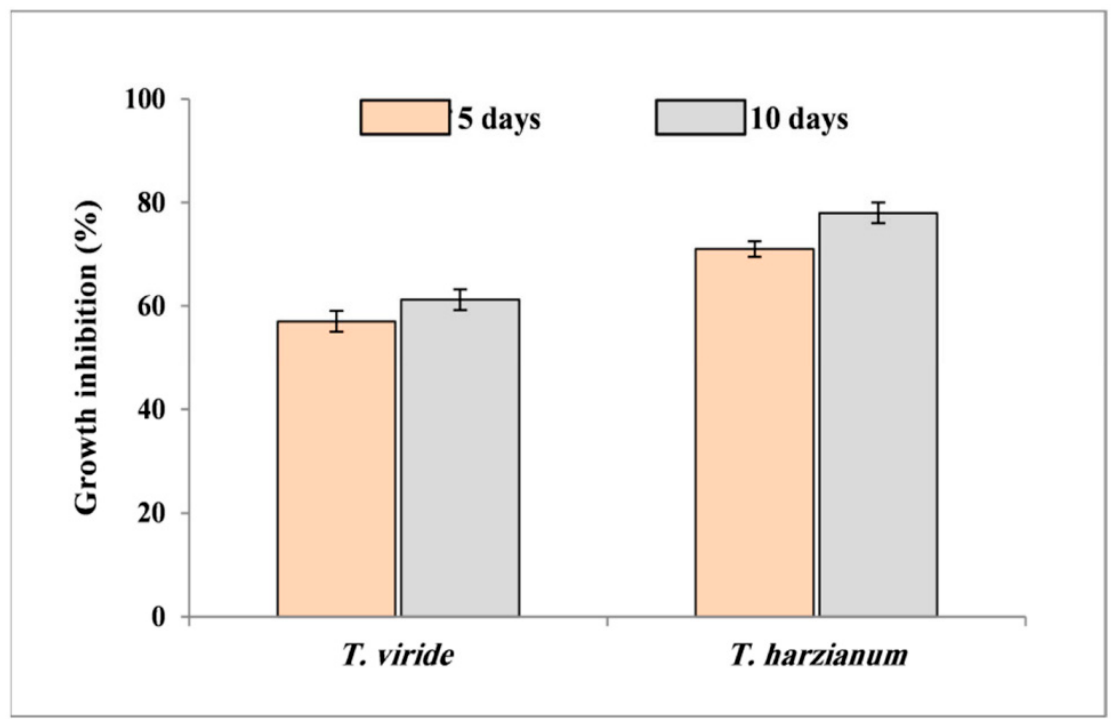
Figure 3. Bar graph represents the percentage of growth inhibition of the pathogenic mycelia of F. solani by Trichoderma spp. ( T. viride and T. harzianum ) 5 and 10 days post-inoculation, through dual culture assay. Error bars represent standard deviation of the mean.